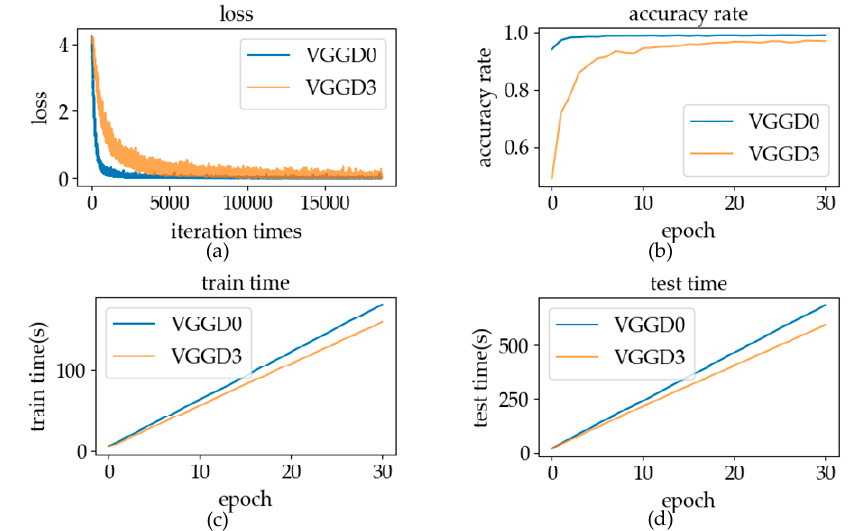
Figure 20. The effect diagram of BN. Each subgraph in this diagram has exactly the same meaning as in Figure 18. Wherein the VGGD0 represents the use of BN and the VGGD3 represents unused.